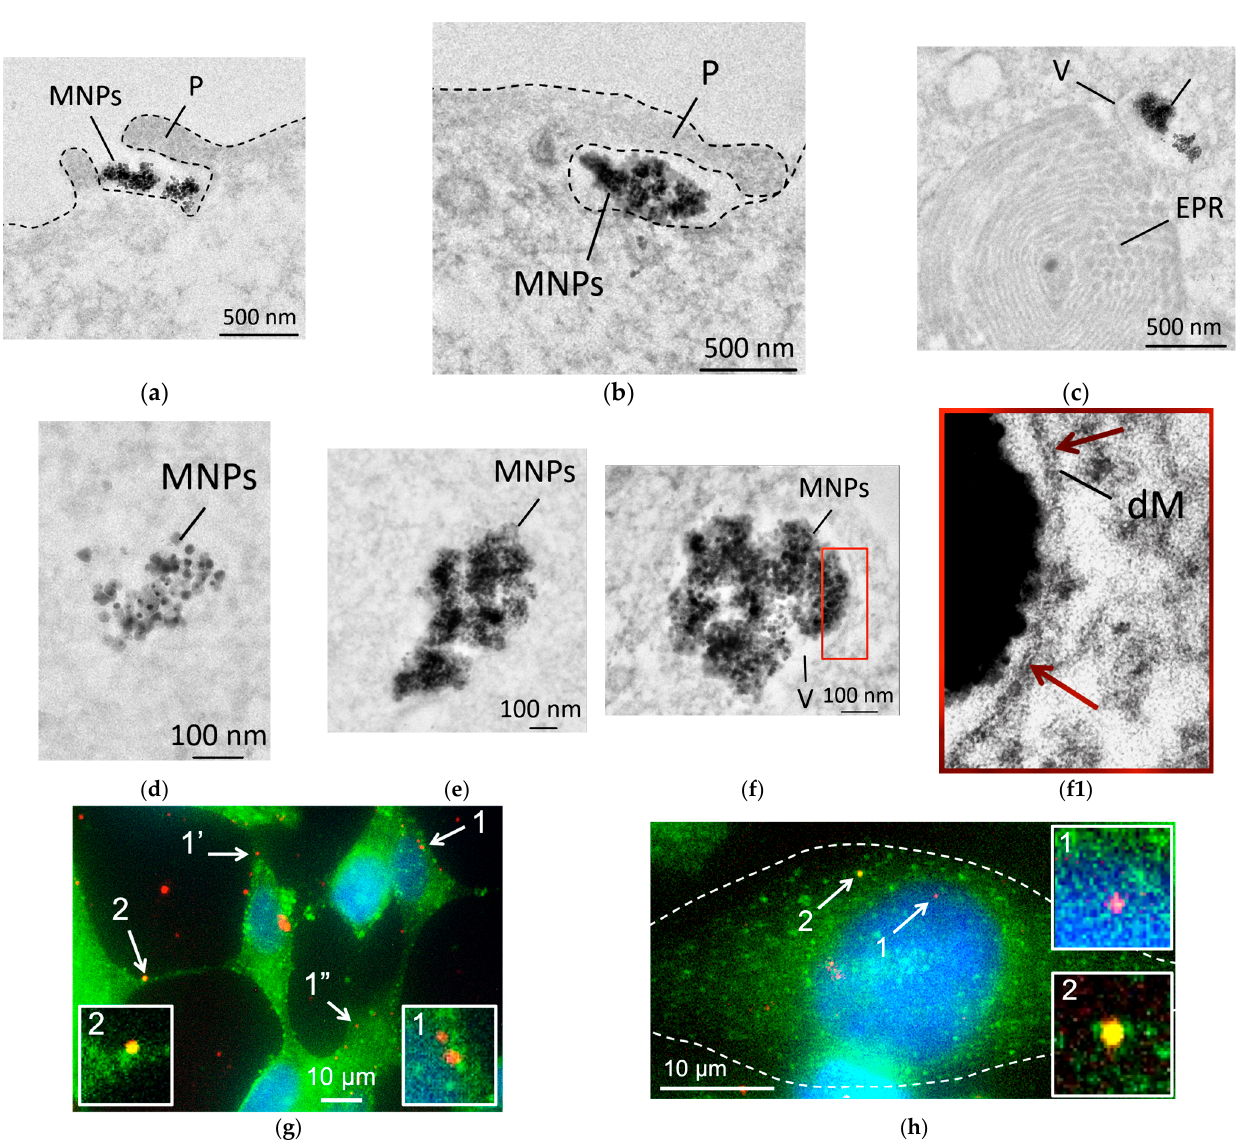
Figure 5. Magnetite–gold dumbbell nanoparticle internalization by cells and localization inside them. ( a ) Pseudopodia formation by cell; ( b ) Complete surrounding of MNP conglomerate by cell plasma membrane; ( c ) MNP localization inside cell vesicle; ( d , e ) Localization of MNP conglomerates with different sizes inside cell cytoplasm; ( f ) Location of MNP conglomerate inside double-membrane vacuole; ( f1 ) Magnified view of the inset. Abbreviations: dM—double membrane; EPR—endoplasmic reticulum; MNPs—magnetic nanoparticles; P—pseudopodium formed by a cell plasma membrane; V—vesicle/vacuole. Arrows show the double membrane. Dotted lines indicate the cell boundaries. ( g , h ) Detection of MNP-Cy5 localization inside lysosomes in LNCaP and PC-3 cells, correspondingly. Fluorescent microscopy: green—cell vesicles stained with anti-LAMP1 antibodies, blue—cell nuclei stained with DAPI; red—MNPs labeled with Cy5. The 1, 1 ′ and 1” show the MNP conglomerates, which are not situated inside the acidic vesicular compartment of the cells; 2—MNPs inside lysosome (Cy5 and anti-LAMP1 dye co-localization); frames 1 and 2—magnified views of corresponding areas; dotted lines indicate the cell boundaries.